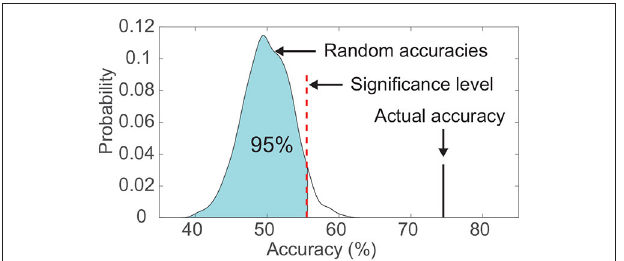
FIGURE 3 | Comparison between the actual classification accuracy and the empirical distribution of random accuracies. The significance level was set as the accuracy corresponding to the 95th percentile of the empirical distribution. This example data was from subject S6’s visual